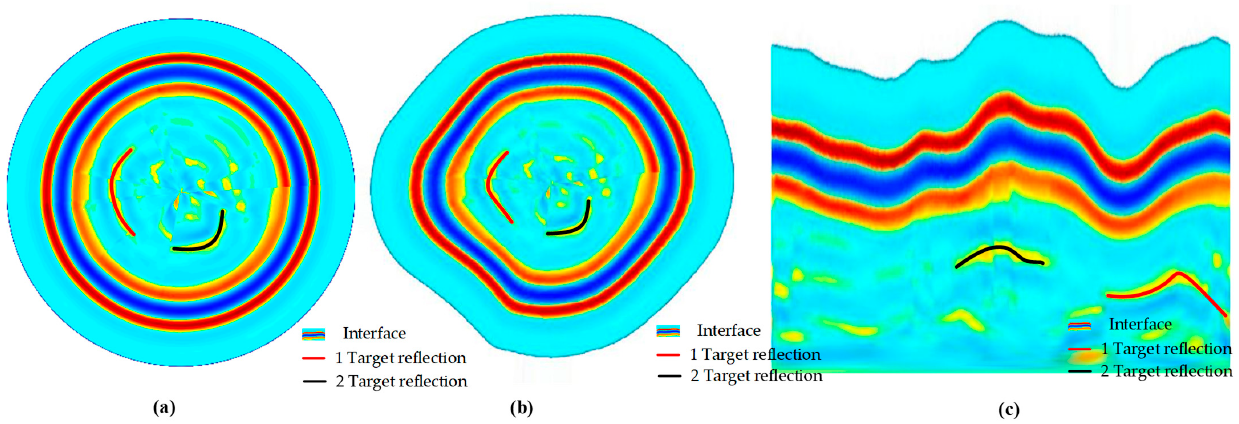
Figure 12. Radar images of the irregular tree stump. ( a ) Radar image in the circular domain; ( b ) radar image of the irregular tree trunk; ( c ) radar image features in the physical domain.